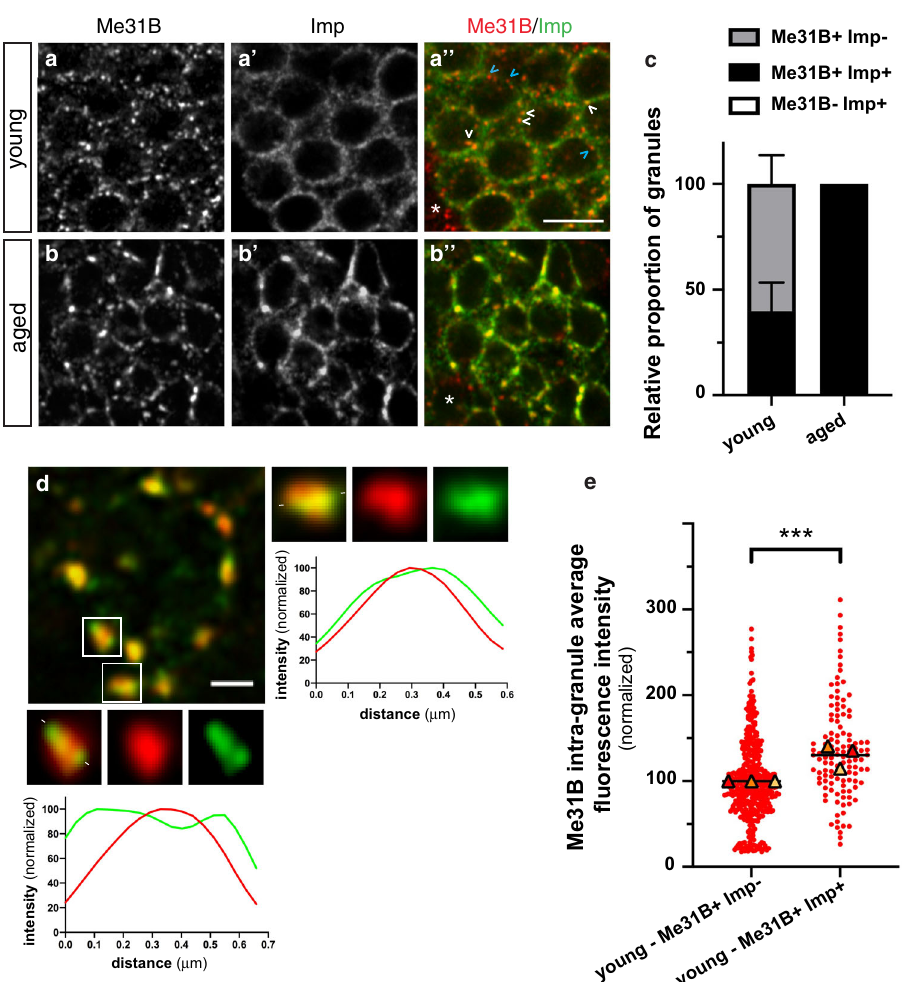
Fig. 3 Age-dependent changes in RNP granule composition. a , b Cell bodies of MB γ neurons imaged from 1 – 2 day- ( a , young) or 37 – 38 day- ( b , aged) old brains. GFP-Imp- (gray in a ’ , b ’ and green in the overlay) expressing brains were stained with anti-Me31B antibodies (gray in a , b and red in the overlay). The white arrowheads point to Me31B + Imp + granules while the blue ones point to Me31B + Imp- granules. Asterisks in a ” , b ” indicate non-MB γ neurons that do not express Imp. Scale bar: 5 μ m. c Relative proportions of Me31B + Imp- and Me31B + Imp + granules in young and aged fl ies. The fraction of Me31B + granules containing Imp was estimated using the JACoP plugin of Fiji (see Method), and values normalized to the aged condition. Three replicate experiments, with at least 10 samples per condition were performed and averaged. Error bar represents s.e.m. Note that no Me31B − Imp + granules could be observed. d Left: cell body of a 38 day-old MB γ neuron expressing GFP-Imp (green) and stained with anti-Me31B antibodies (red). Scale bar: 1 μ m. Magni fi cations of the boxed areas are shown in the lower and right panels. Intensity pro fi les of GFP-Imp (green) and Me31B (red) measured along the line marked by white segments are shown below magni fi ed images. e Concentration of Me31B-GFP in granules negative (left) or positive (right) for Imp in 1 – 2- day-old brains. Three replicates were performed and the mean value of each replicate is indicated as a symbol (triangle). Data points were color-coded based on the experimental replicate they belong to and normalized to the values found in Me31B + Imp- granules. *** P < 0.001 (unpaired, two-sided t -test on individual data points). Source data are provided as a Source Data fi